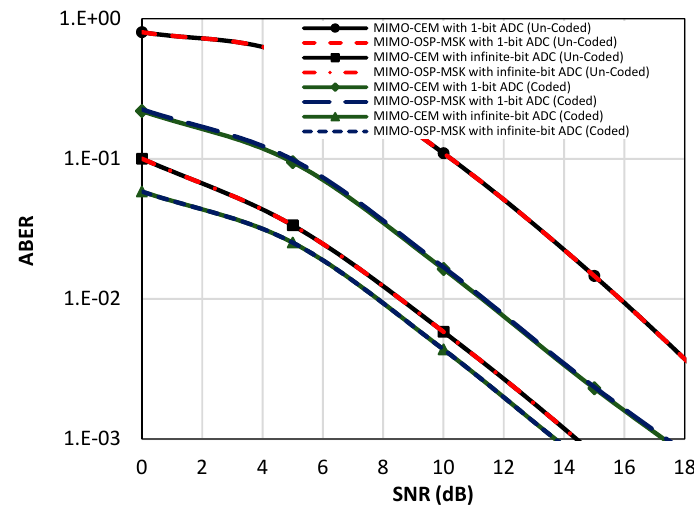
Figure 8. The ABER performance of the proposed MIMO-OSP-MSK compared to the ABER of the conventional MIMO-CEM system with quantization errors (i.e., one-bit ADC is utilized) and without quantization errors (i.e., infinite-bit ADC is utilized) for the uncoded and coded scenarios.